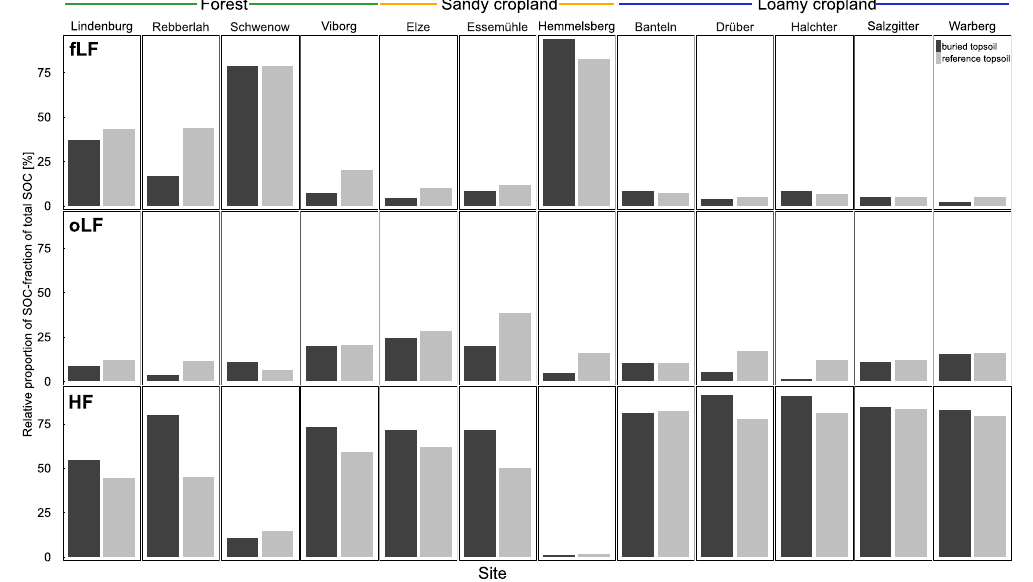
Figure 4. Relative proportion of free light fraction (fLF), occluded light fraction (oLF) and heavy fraction (HF) of total SOC in buried topsoil stripes and reference topsoil.